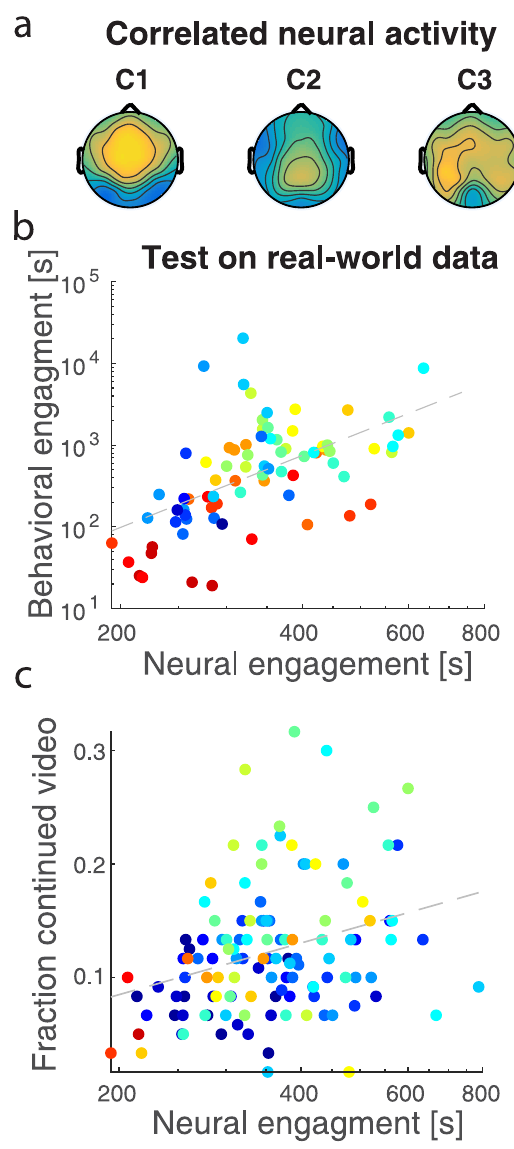
Figure 2. Neural Engagement predicts Behavioral Engagement. ( a ) Spatial distribution of the three EEG components with maximal inter-subject correlation (ISC; C1–C3). Color indicates positive (yellow) or negative (blue) correlation between the source of the neural responses and each sensor on the scalp. Component C2, center, contributes most to the relationship between neural and behavioral engagement (see main text). ( b ) Neural engagement ( ˆ E t ( ) ; dashed line) predicts real-world behavioral engagement, E t ( ) using the model developed on the experimental behavioral engagement data (r = 0.56, p = 0.003, N = 78, for the 5 testing videos, ∆ t = 12 s). ( c ) Neural engagement correlated with the fraction of a separate cohort of viewers that decided to continue to watch the videos when given the option to stop prematurely. Dashed line represents the regression line (r = 0.31, p = 0.0006, N = 122 intervals from all 10 videos). Each point represents a different time interval in each video colored according to time as in Fig. 1. Both engagement measures are displayed on a log-seconds